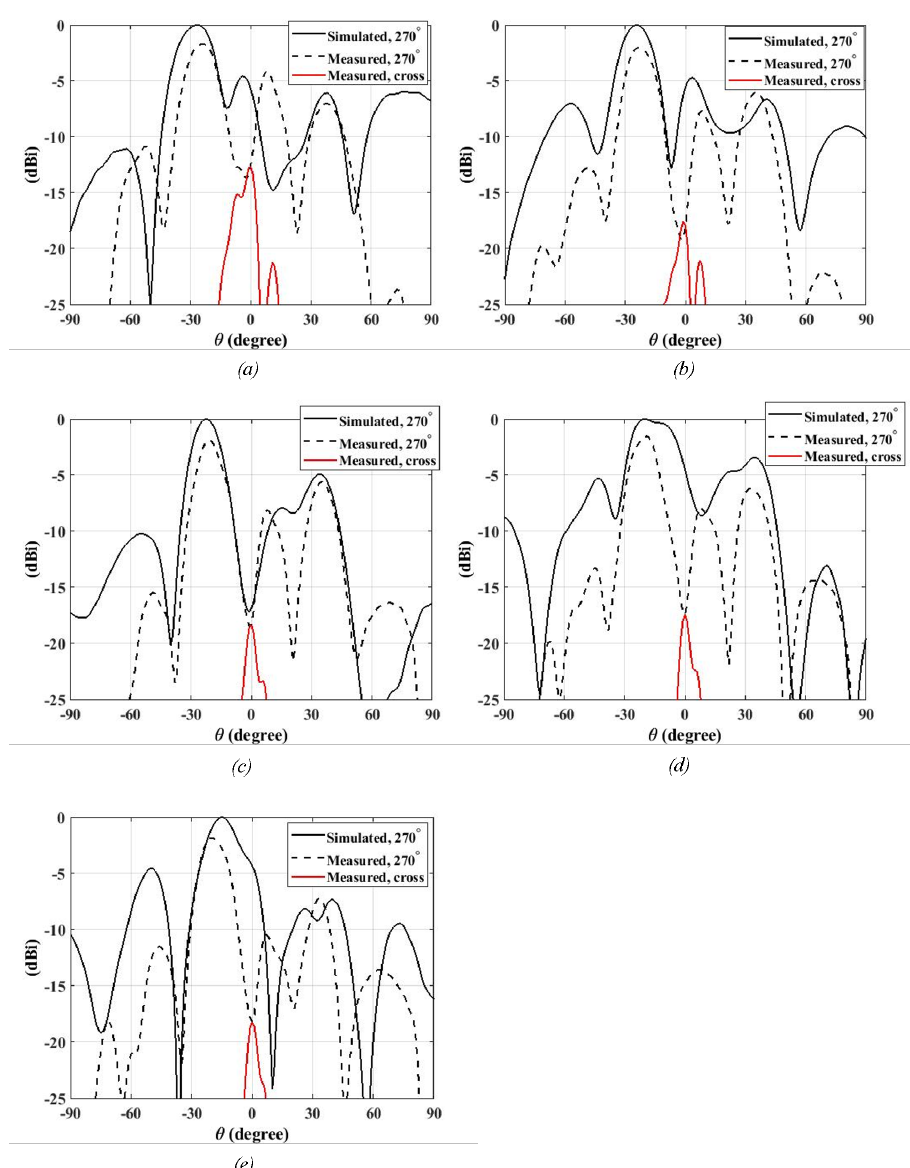
Figure 15. Simulated and measured E-field radiation patterns as well as cross polarization values as observed with the use of the BDS prototype above the feed horn for 270 ◦ orientation ( a ) 11, ( b ) 11.5, ( c ) 12, ( d ) 12.5, ( e ) 13